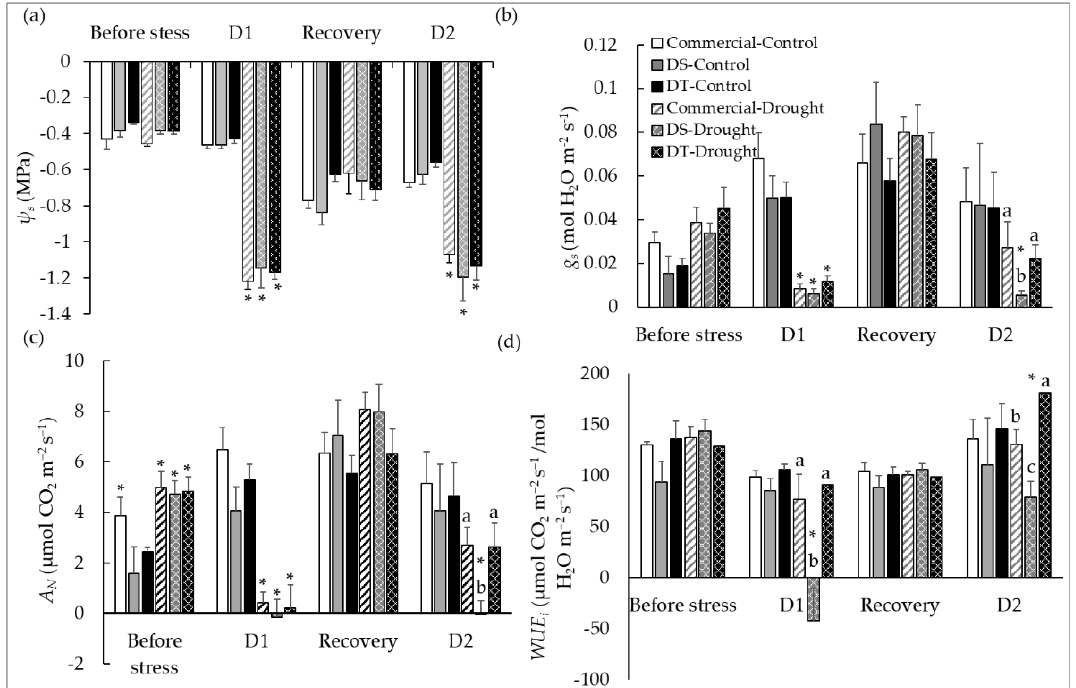
Figure 3. Variations in ( a ) mid-day stem water potential ( ψ s ), ( b ) stomatal conductance ( g s ), ( c ) net carbon assimilation ( A N ), and ( d ) instantaneous water use efficiency ( WUE i ) in commercial, DS and DT clones before imposition of the stress, at the first drought cycle (D1), after rewatering and at the second drought cycle (D2). Values are means ± SEM of 4-9 biological replicates. Statistical analysis was conducted using two-way ANOVA. Asterisks indicate statistically significant differences ( p < 0.05) between drought-treated clones and controls at each treatment. Lowercase letters indicate statistically significant differences ( p < 0.05) between drought treated clones within each treatment.